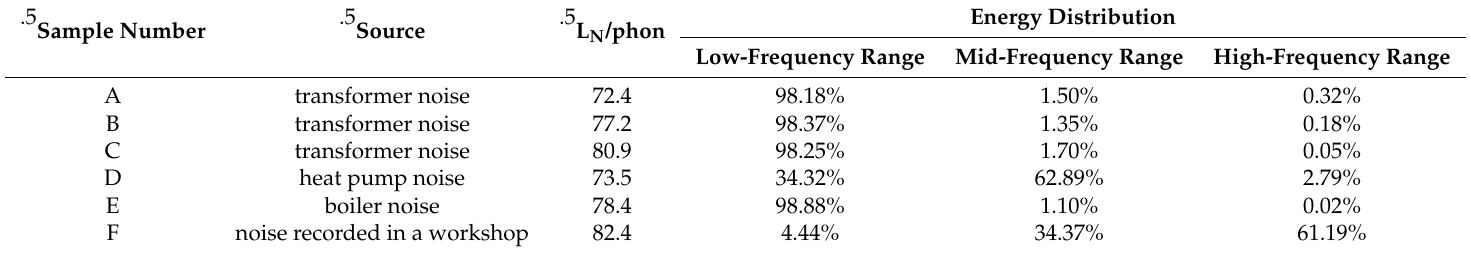
Table 1. Sources, loudness levels, and energy distribution in different frequency ranges of six identical noise samples (samples A–E).